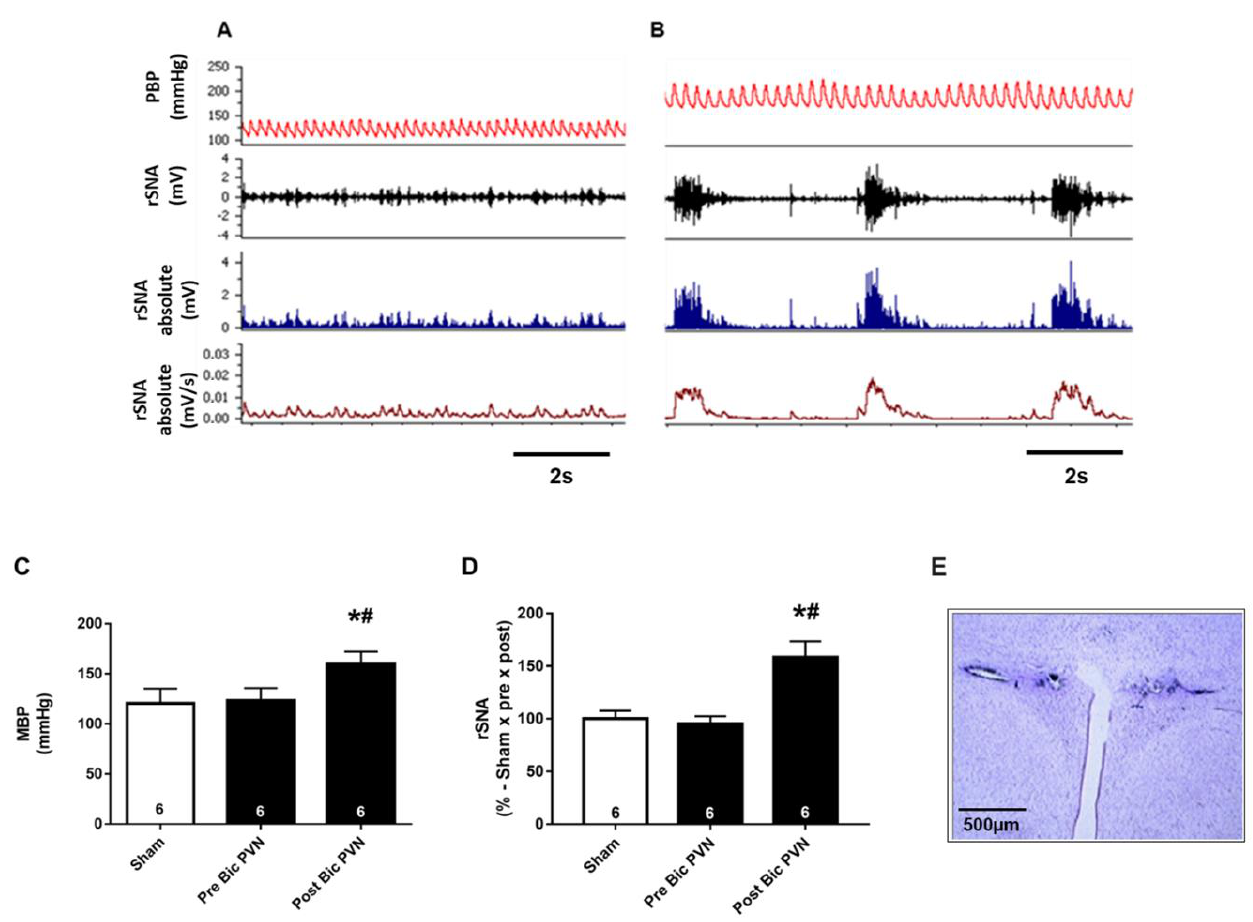
Figure 1. Effect of bicuculline injection into the paraventricular nucleus of the hypothalamus (Bic PVN) on mean arterial pressure (MAP) and renal sympathetic nerve activity (rSNA). ( A ) Typical trace containing pulsatile blood pressure (PBP) and rSNA of sham (whole experiment) and Bic PVN (at baseline before bicuculline infusion) groups. ( B ) PBP of the Bic PVN group after bicuculline infusion. Filtered signal from rSNA (black trace, second from top to bottom in ( A , B ) was first converted to positive absolute values (rSNA absolute, blue traces third from top) and then to mV/s (rSNA absolute mV/s, red lines bottom traces); see methods for more details. White bar represents the MAP of the sham group during with the experiment, and black bars represent the MAP of the Bic PVN group before and after Bic injection ( C ). White bar represents the MAP of the sham group during the experiment; black bars represent the rSNA of the Bic PVN group before and after Bic infusion ( D ). Representative histological image: arrow indicates the site of microinjection into the PVN. Scale bar = 500 µ m. 3 V, third ventricle ( E ). The number of rats is indicated inside the bars. * p < 0.001 compared to sham. # p < 0.001 compared to pre-Bic PVN. One-way analysis of variance for multiple comparisons followed by Tukey’s